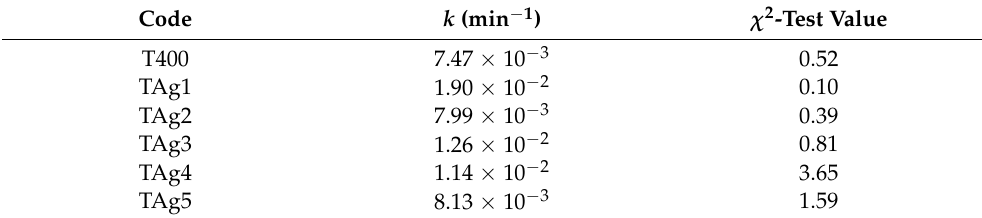
Table 3. Kinetic parameters for MB dye photodegradation under visible light in the presence of Ag–TiO 2 nanostructured nanofibers